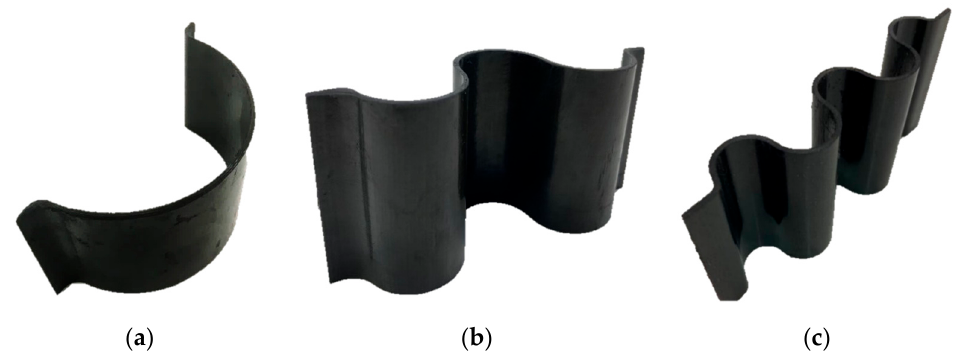
Figure 4. Manufactured semi-circle ( a ) and sinusoidal specimens with 3 ( b ) and 5 curvatures ( c ).